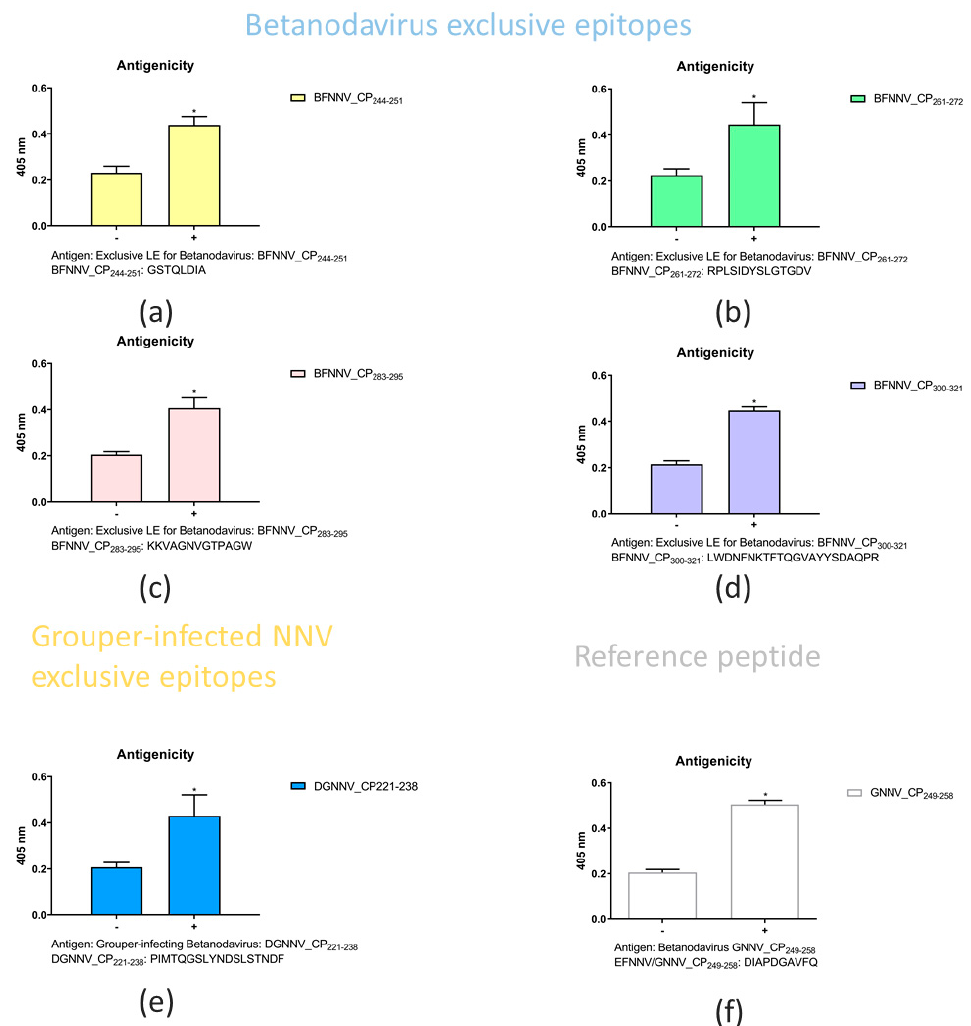
Figure 2. Enzyme-linked immunosorbent assays (ELISAs) were performed to identify host-specific LEs. From ( a – d ), 4 betanodavirus exclusive epitopes; ( e ) grouper-infecting virus exclusive epitope; ( f ) a reference peptide. The symbol “-” represents the case of pre-immunization (without immu- nization), and “+” represents after immunization (rabbit antibody was immunized by NNV capsid protein). All ELISA values were further analyzed by GraphPad Prism 8.0 software with t-test ( n = 3, * p < 0.05). Detailed experimental data can be found in Supplementary Tables S1 and S2.